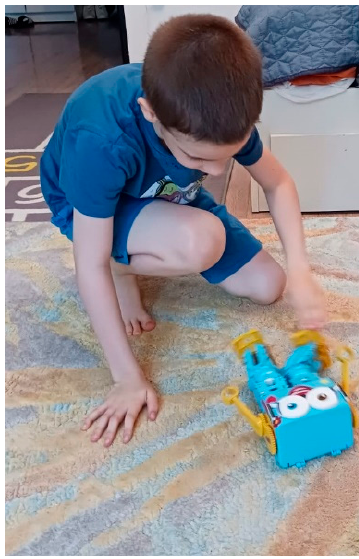
Figure 19. Child’s interaction with Marty robot.